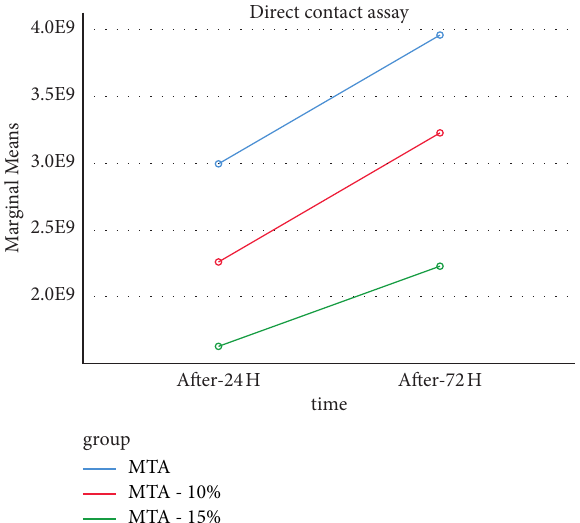
Figure 3: The linear graph of the comparison of the groups with the DCA test.